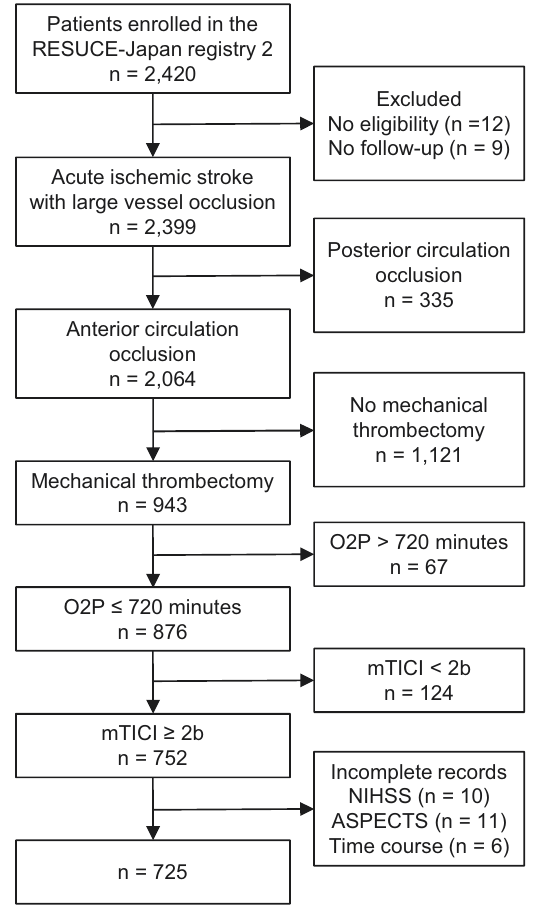
Figure 1. Patient selection. ASPECTS, Alberta Stroke Program Early Computerized Tomography Score; mTICI, modified thrombolysis in cerebral infarction; NIHSS, National Institutes of Health Stroke Scale; O2P,